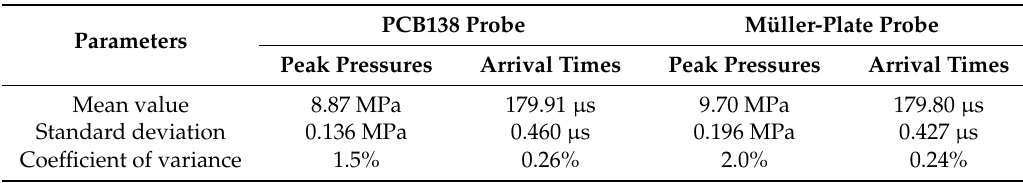
Table 2. Statistical analysis of peak pressures and arrival times.